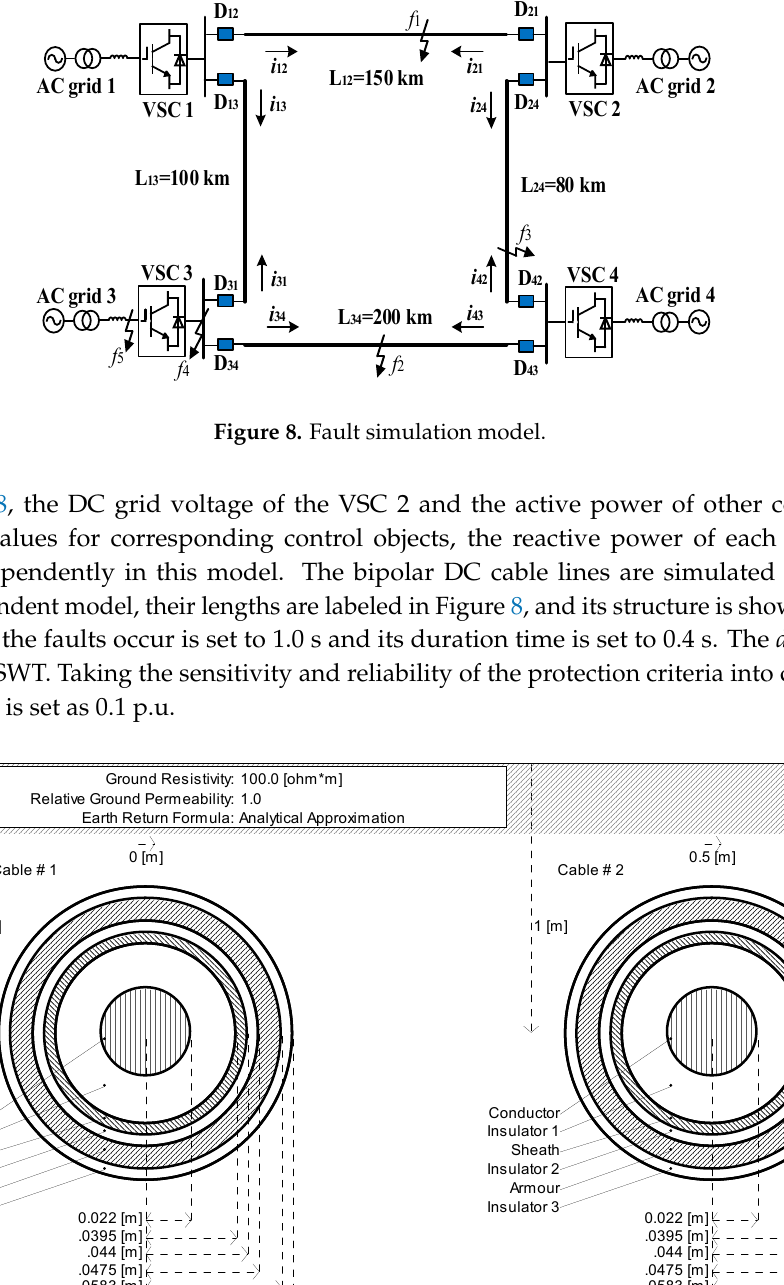
Figure 9. The structure of bipolar DC cable lines.